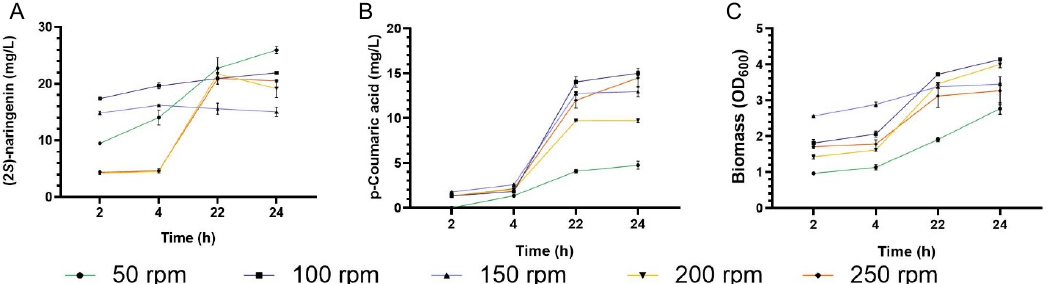
Figure 2. The (2 S )-Naringenin heterologous production in different aeration conditions at a laboratory scale. ( A ) The (2 S )-naringenin heterologous production in E. coli . ( B ) The p-Coumaric acid heterologous production in E. coli . ( C ) Cell growth of E. coli .